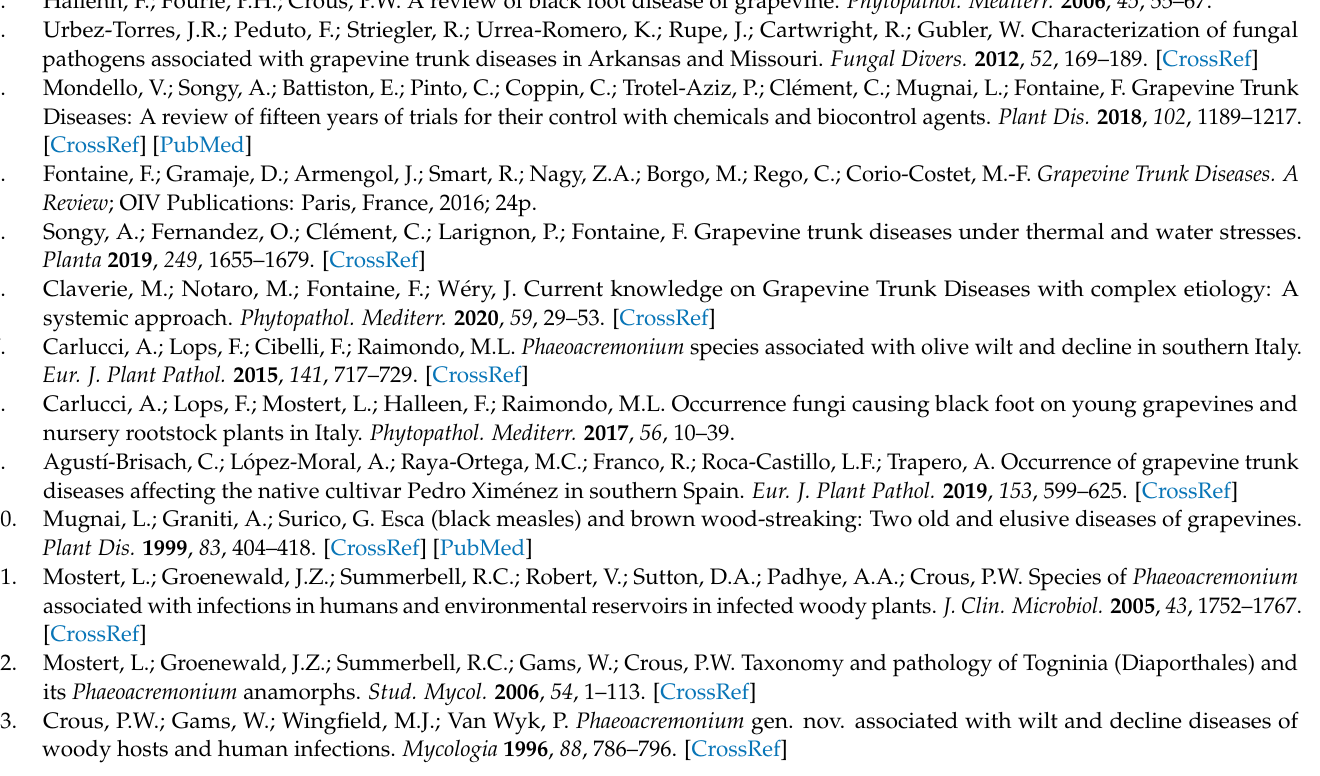
10.3390/jof8010055/s1, Figure S1: (a) XIC of MRM transitions of scytalone ( 1 ); (b) XIC of MRM transitions of isosclerone ( 2 ); (c) selected MRM transitions for scytalone ( 1 ); (d) selected MRM transitions for isosclerone ( 2 ). Figure S2: Hierarchical Clustering result shown as dendrogram. In red the extracts at unmodified pH, in green the extracts after acidification (pH 2) with formic acid. Table S1: Calibration curves, correlation coefficient (r), imprecision, inaccuracy, LOD and LOQ value for scytalone ( 1 ) and isosclerone ( 2 ) quantification. Table S2: Within-day imprecision (CV %) and Table S3: Between-day imprecision (CV %) and inaccuracy (%) of results obtained by measuring two QC levels once a day for five days ( n = 5). Table S4: Workflow parameters Mzmine